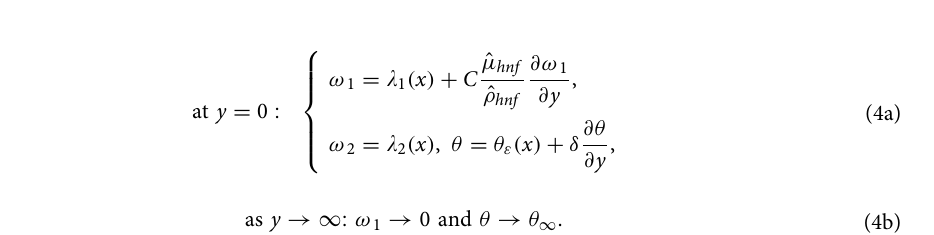
Table 2. The physical properties of ethylene glycol, graphene and MoS 2 2,35 .